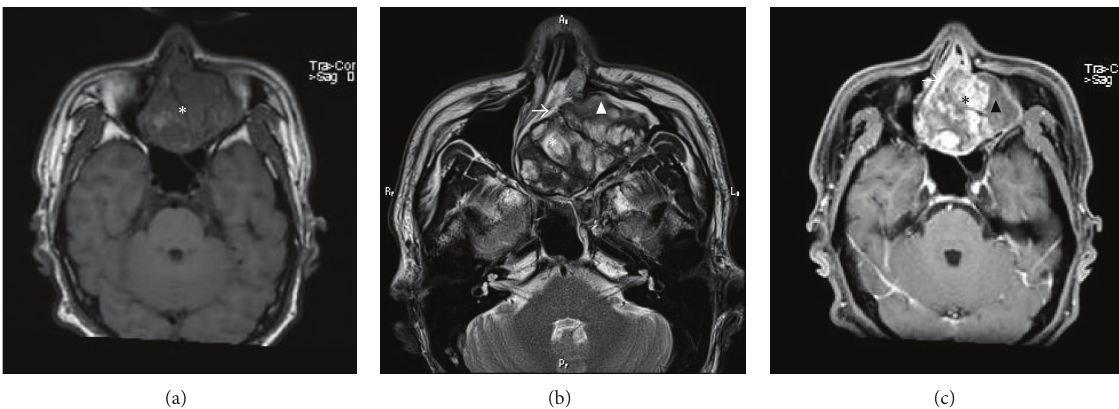
Figure 2: MRI findings of Case 1. (a) On T 1 -weighted imaging, the central region ( ∗ ) has a slightly lower intensity compared to that of the muscle. (b) On T 2 -weighted imaging, the central region ( ∗ ) demonstrates high intensity, and the periphery ( 󳵳 ) has lower intensity than the central region. Thickening of the paranasal mucosa is observed ( → ). (c) On contrast-enhanced T 1 -weighted imaging, the central region is strongly enhancing ( ∗ ), while the periphery ( 󳵳 ) demonstrates less enhancement than the central region. Additionally, the thickened mucosa of the paranasal sinus are strongly enhanced ( →